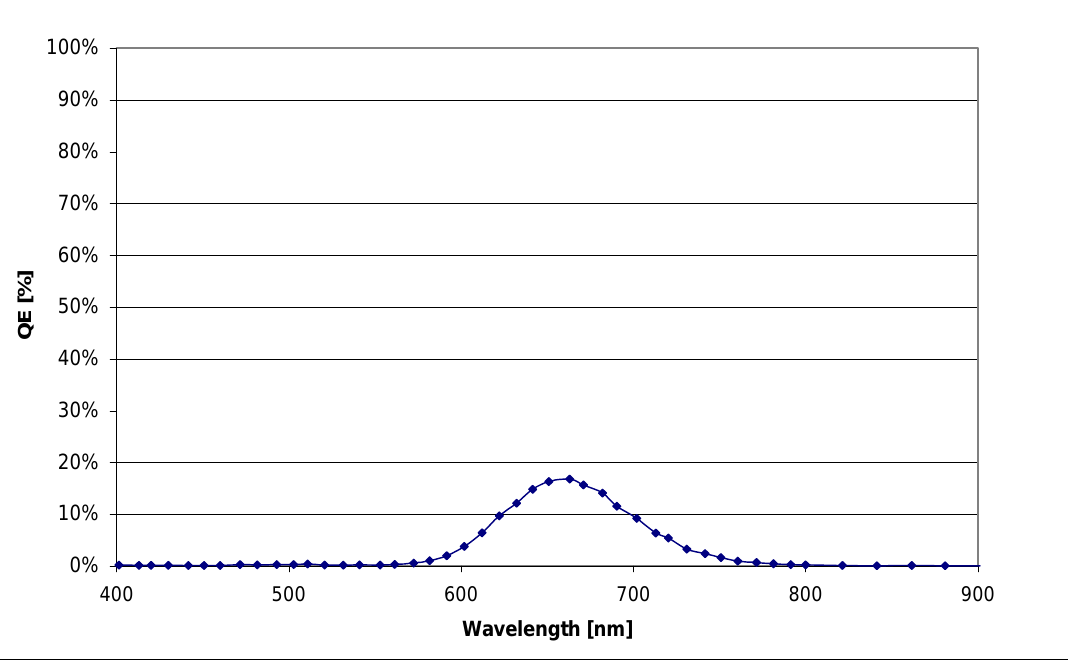
Figure 9. TFC Simulation Results wit ASA for different PIN diode thicknesses